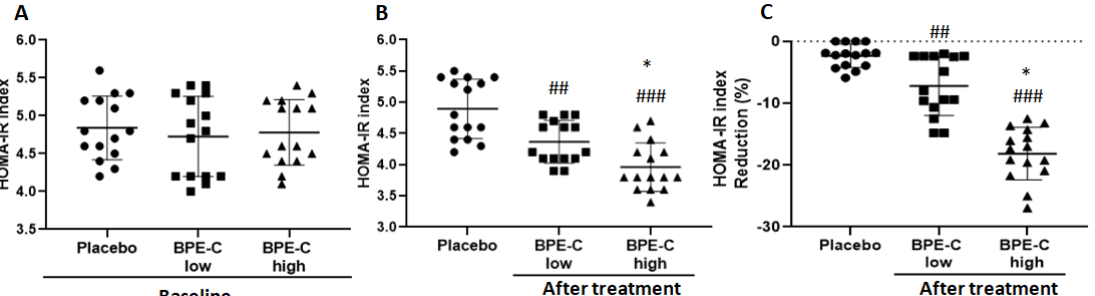
Figure 5. BPE-C improves insulin sensitivity by a significant reduction of HOMA-IR index in MetS patients. ( A ) HOMA-IR before treatment and ( B ) after 90-days treatment with BPE-C or placebo. ( C ) Percent change of HOMA-IR with respect to baseline values. Statistical differences were analyzed by ANOVA test followed by Bonferroni’s post-hoc test (A and B) and Kruskal–Wallis test followed by Dunn’s test (C). Horizontal bars show the mean of 15 patients ± SD. The analysis revealed a highly significant HOMA-IR decrease after the treatment with BPE-C at ## p ≤ 0.01 or ### p ≤ 0.001 for low and high doses, respectively. The response to BPE-C was dose-dependent at * p ≤ 0.05. As expected, a significant reduction was also observed in serum insulin concentrations ( p < 0.001)